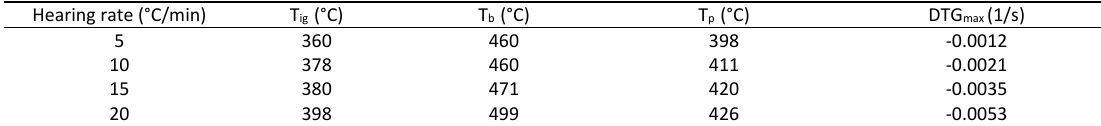
Table 7: Combustion characteristics of pellets in combustion at various heating rates Hearing rate (°C/min)